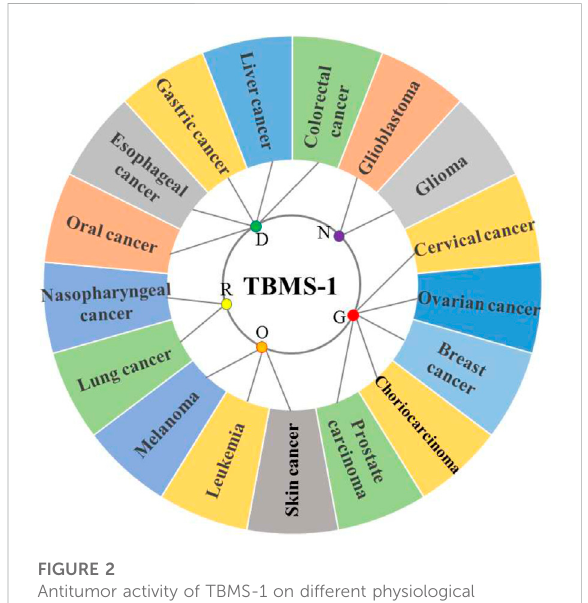
FIGURE 2 Antitumor activity of TBMS-1 on different physiological systems (R = respiratory system tumor, D = digestive system tumor, N = nervous system tumor, G = genital system tumor, O = other system